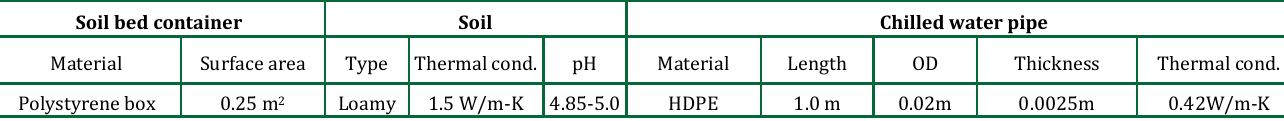
Table 1: Soil bed and chilled water pipe